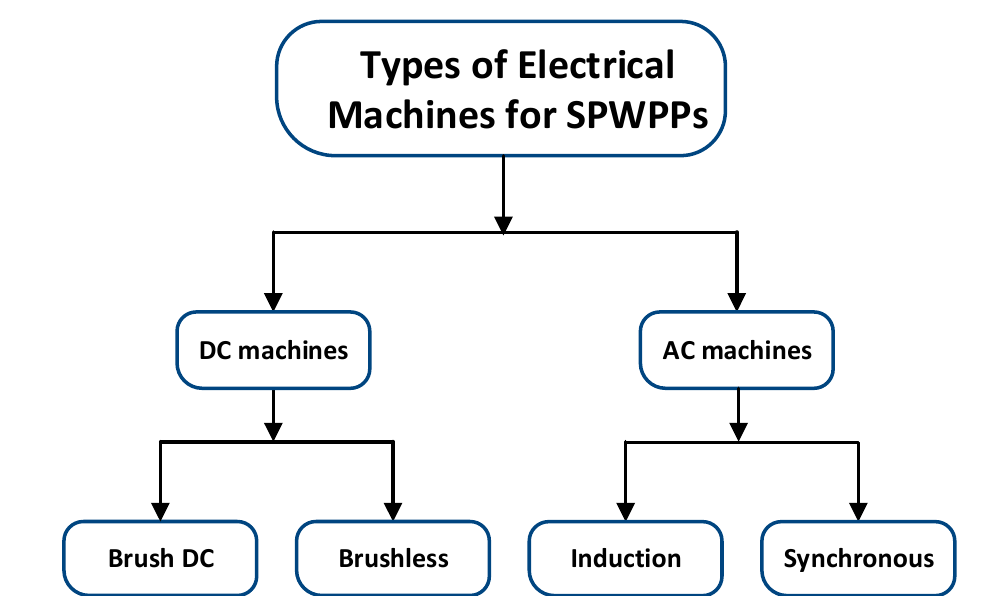
Figure 4. Main types of electrical machines for photovoltaic pump applications. Table 2. Advantages and disadvantages of DC machines.